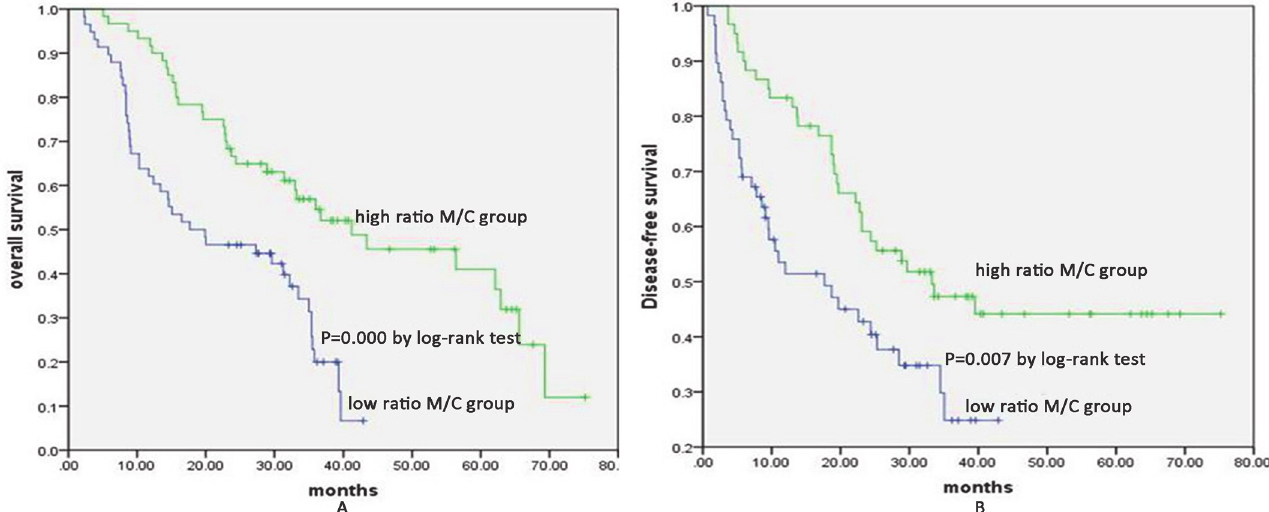
Fig 3. Kaplan-Meier estimates of the OS and DFS according to the rate of membrane expression to whole cellular expression (M/C) in ESCC patients. A. Kaplan-Meier curves illustrating the OS of the high M/C ratio group versus the low M/C ratio group. Five-year OS of the high ratio M/C group was significantly higher compared to that of the low M/C ratio group (41.0% vs. 6.7%, P = 0.000); B. Kaplan-Meier curves illustrating the DFS of the high M/C ratio group versus the low M/C ratio group. Five-year DFS of the high M/C ratio group were significantly higher compared to those of the low M/C ratio group (44.1% vs. 24.9%, P = 0.007).